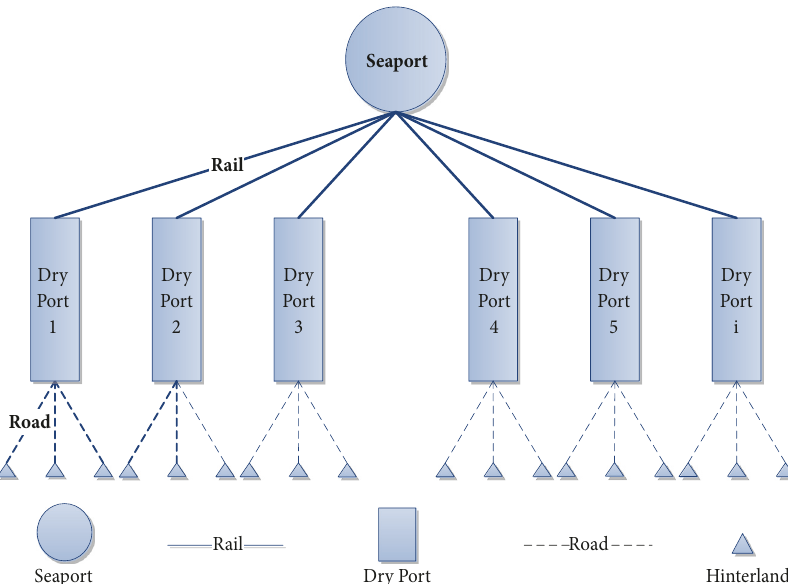
Figure 1: Correlations between a seaport and its dry ports and